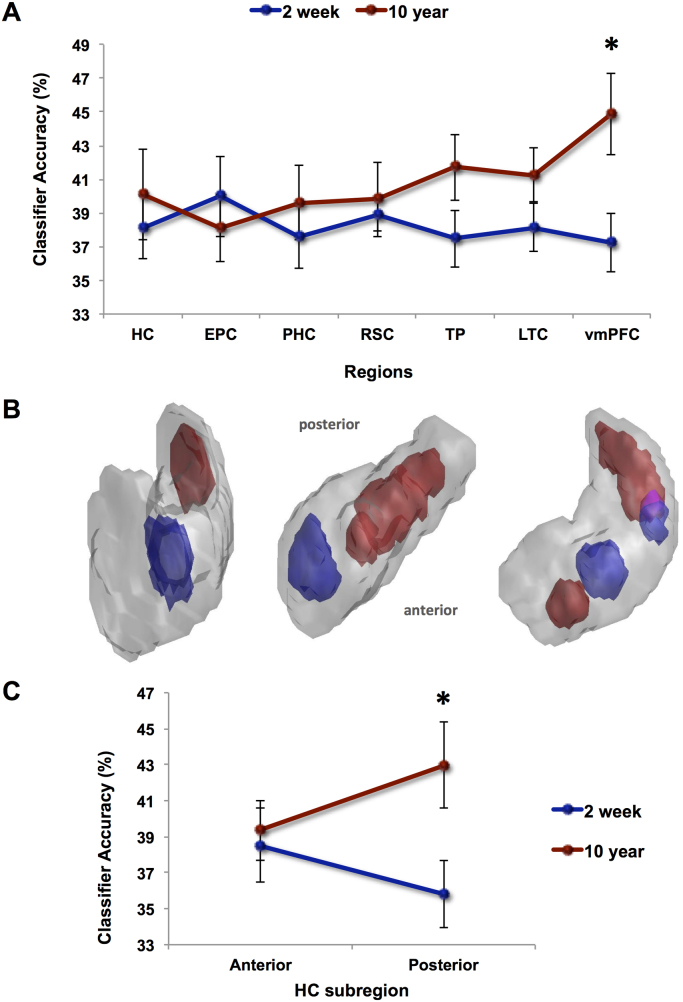
MVPA results for recent and remote autobiographical memories in study one. A. Hippocampus (HC), entorhinal and perirhinal cortices (EPC), parahippocampal cortex (PHC), retrosplenial cortex (RSC), temporal pole (TP), lateral temporal cortex (LTC), and ventromedial prefrontal cortex (vmPFC) were examined. Chance=33%. Recent (blue line) and remote (red line) autobiographical memories were represented in medial temporal regions, including the hippocampus, while in vmPFC remote memories were particularly distinguishable; *p<0.05. The difference between recent and remote memories in TP just failed to reach significance. Error bars represent ±1 standard error of the mean. B. Information maps in the hippocampus for recent (shown in blue) and remote (shown in red) autobiographical memories comprised the voxel sets that produced above-chance classification accuracy. The information maps for three example participants are shown superimposed upon 3D images of their right hippocampus. Areas in pink denote where the information maps for recent and remote memories overlapped. C. MVPA results for anterior and posterior subregions of the hippocampus (HC). Above-chance (chance=33%) classification was apparent in anterior and posterior hippocampus for recent (blue line) and remote (red line) memories. Nevertheless, classification accuracies were significantly higher in the posterior hippocampus for remote memories; *p<0.05. Error bars represent ±1 standard error of the mean. (For interpretation of the references to color in this figure legend, the reader is referred to the web version of this article.).